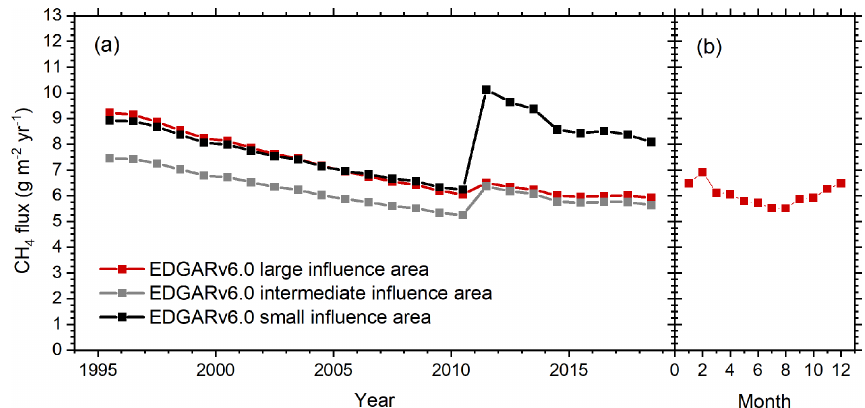
Figure 3. (a) Long-term trends of CH 4 fluxes as reported by the EDGARv6.0 emission inventory (Crippa et al., 2021). Trends for all three influence areas show a significant decrease from 1995 to 2010 of about 30%. In 2011 an abrupt increase is observed, which is largest for the small influence area, due to an artefact of reported emissions in the MA/LU pixel (see text). (b) Seasonal cycle of 2010 emissions in the large influence area of